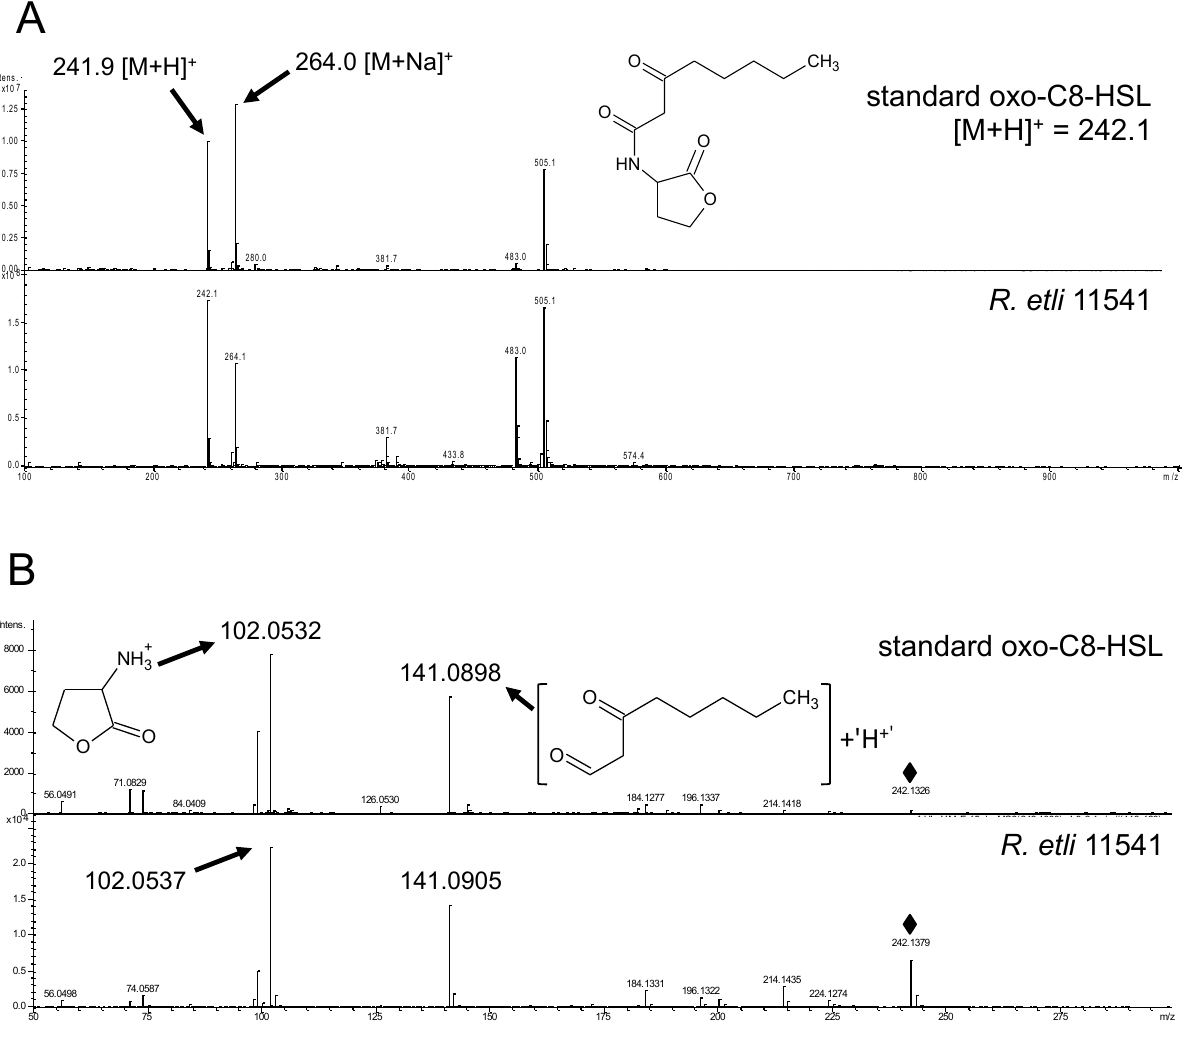
Figure 7. Verification of AHLs production in Rhizobium etli 11541. HPLC samples were screened in the positive ion mode, and a scan from m/z 50 to 500 was performed. ( A ) The MS of standard oxo-C8-HSL standard ( m / z = 242.1 [M + H] + ) shows a pattern similar to AHLs extracted from the R. etli culture; ( B ) Further analysis by MS/MS confirmed the identity of AHL extracted from the R. etli culture with the standard oxo-C8-HSL. The diagnostic fragment ions m / z 102.0532 and 102.0537 are indicative for the presence of the lactone ring. The highlighted m / z values represent diagnostic fragment ions. Diamonds mark the pseudomolecular ions used for MS/MS